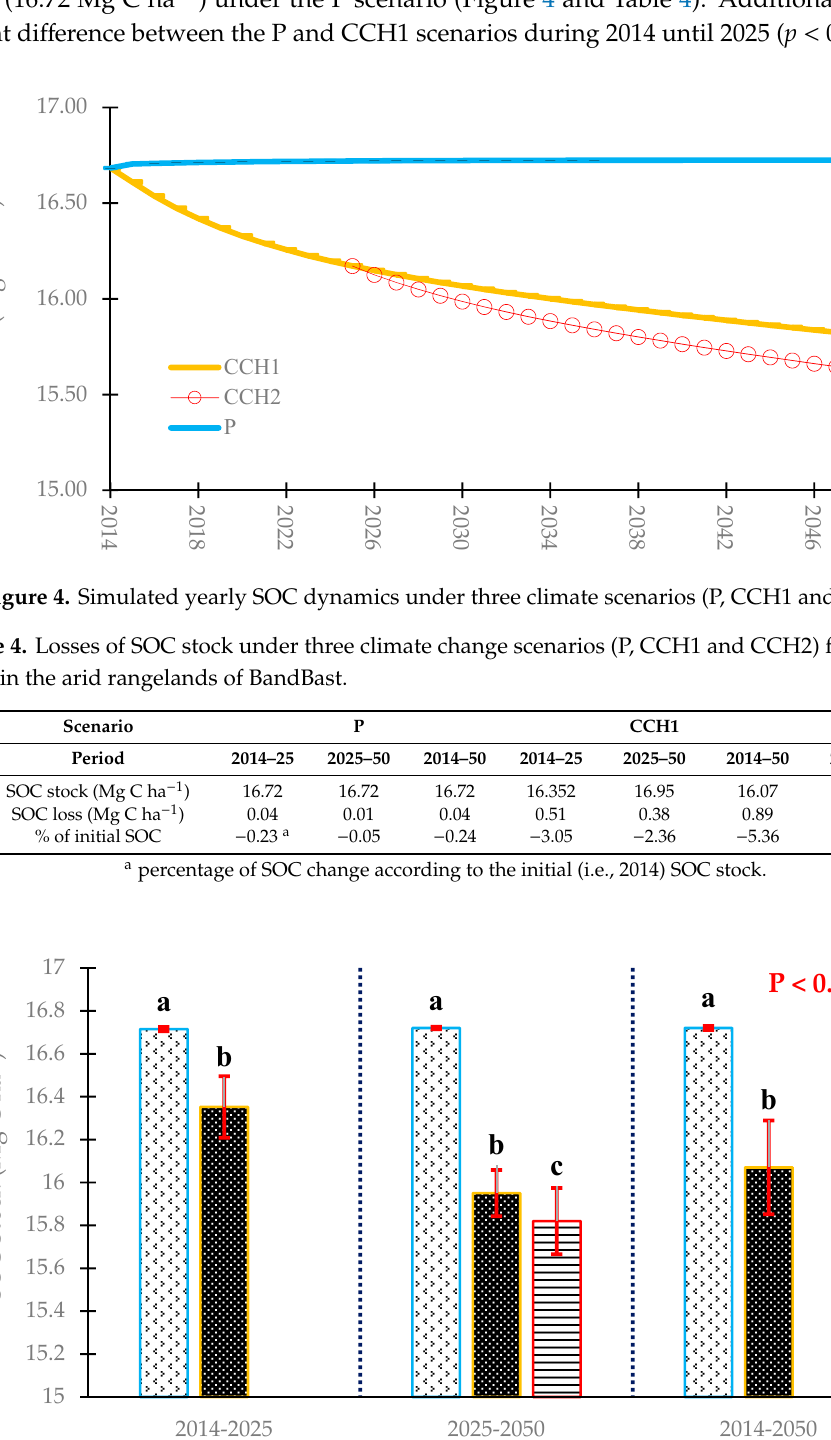
Figure 5. SOC stock for three periods 2014–25, 2025–50 and 2014–50 under different climate scenarios. Different superscript letters represent statistically significant differences between climate scenarios at p < 0.01 according to the least significant difference (LSD) tests. Table 4. Losses of SOC stock under three climate change scenarios (P, CCH1 and CCH2) from 2025 to 2050 in the arid rangelands of BandBast. a percentage of SOC change according to the initial (i.e., 2014) SOC stock.